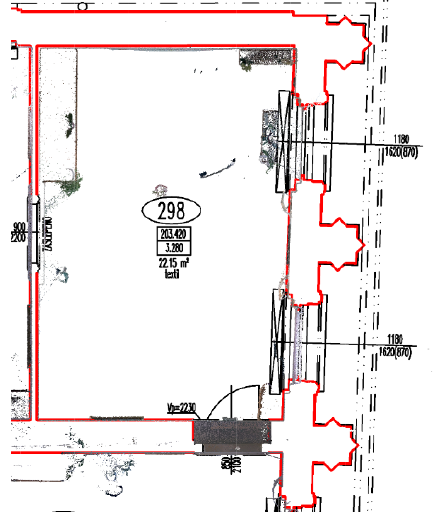
Figure 6 . Detail of comparison of point cloud carried out Leica BLK360 and original